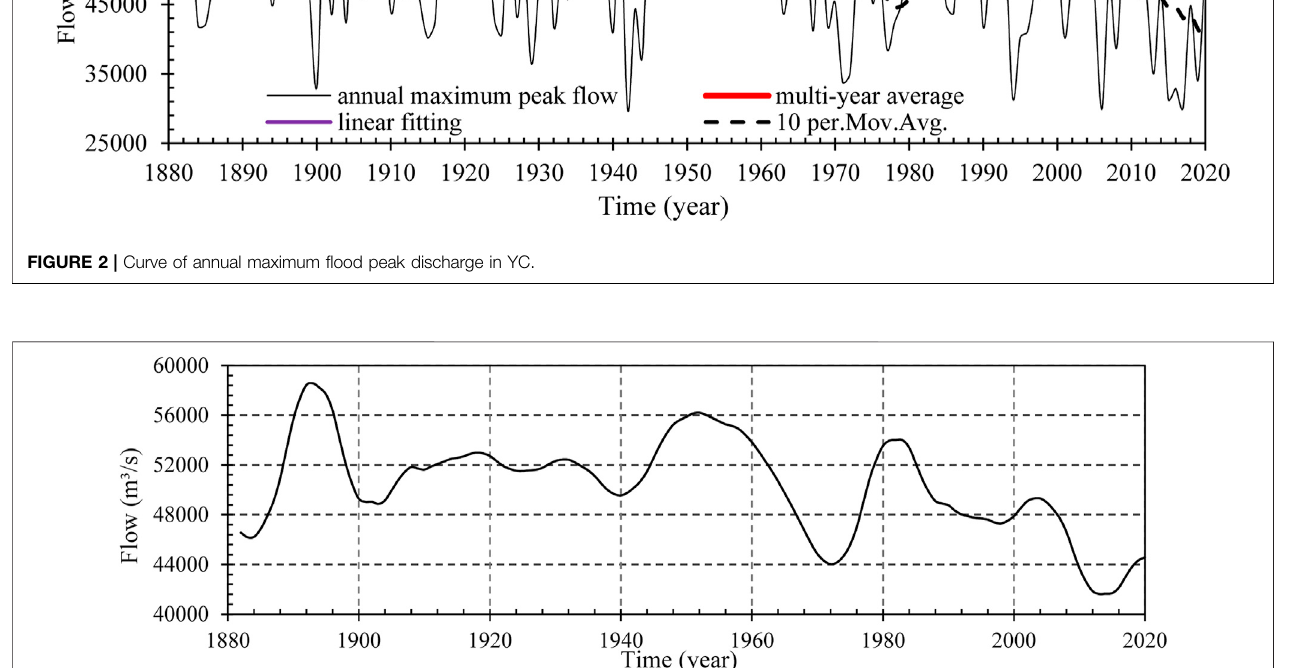
Frontiers in Earth Science |